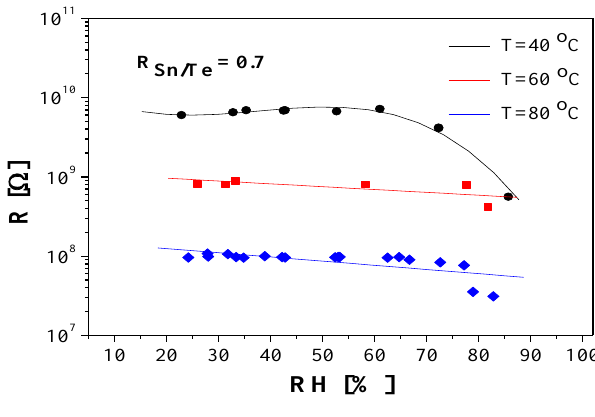
Figure 6. Influence of the temperature on the sensitivity to humidity of amorphous samples with R = 0.7 and thickness of 60 nm. Sn/Te